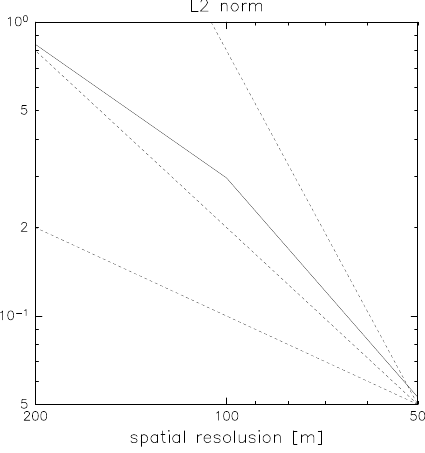
Figure C2. L 2 norm of potential temperature computed against the 25m resolution experiment. Dashed lines represent first-, second-, and fourth-order